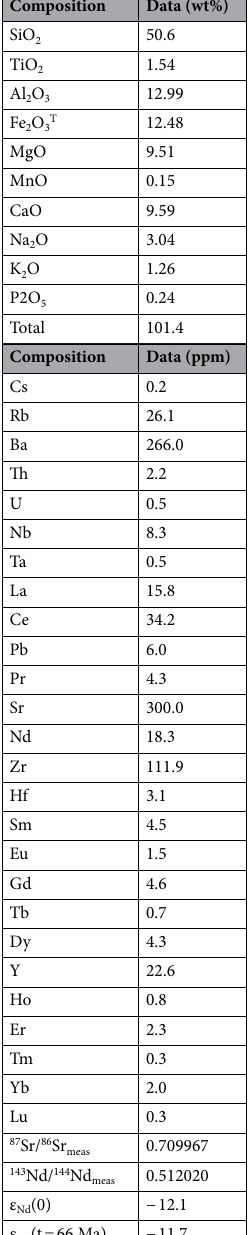
Table 2. Geochemical and Isotopic compositions of the Manikapatna Stone Anchor Major element oxides are in wt% and trace element contents are in ppm. Total iron (superscript T) is reported as ferric oxide. Reproducibility for major oxides is < 3 wt%, for all trace element contents < 2% except for REE for which it is < 1% at 2σ level, based on the repeated analysis of USGS rock standard BHVO-2. The average values for NBS987 and JNdi-1 analysed over a period of 4 years are 87 Sr/ 86 Sr = 0.71023 ± 0.00001 and 143 Nd/ 144 Nd = 0.512104 ± 0.000004 (± 0.1 in ε Nd units) at the 2σ level of